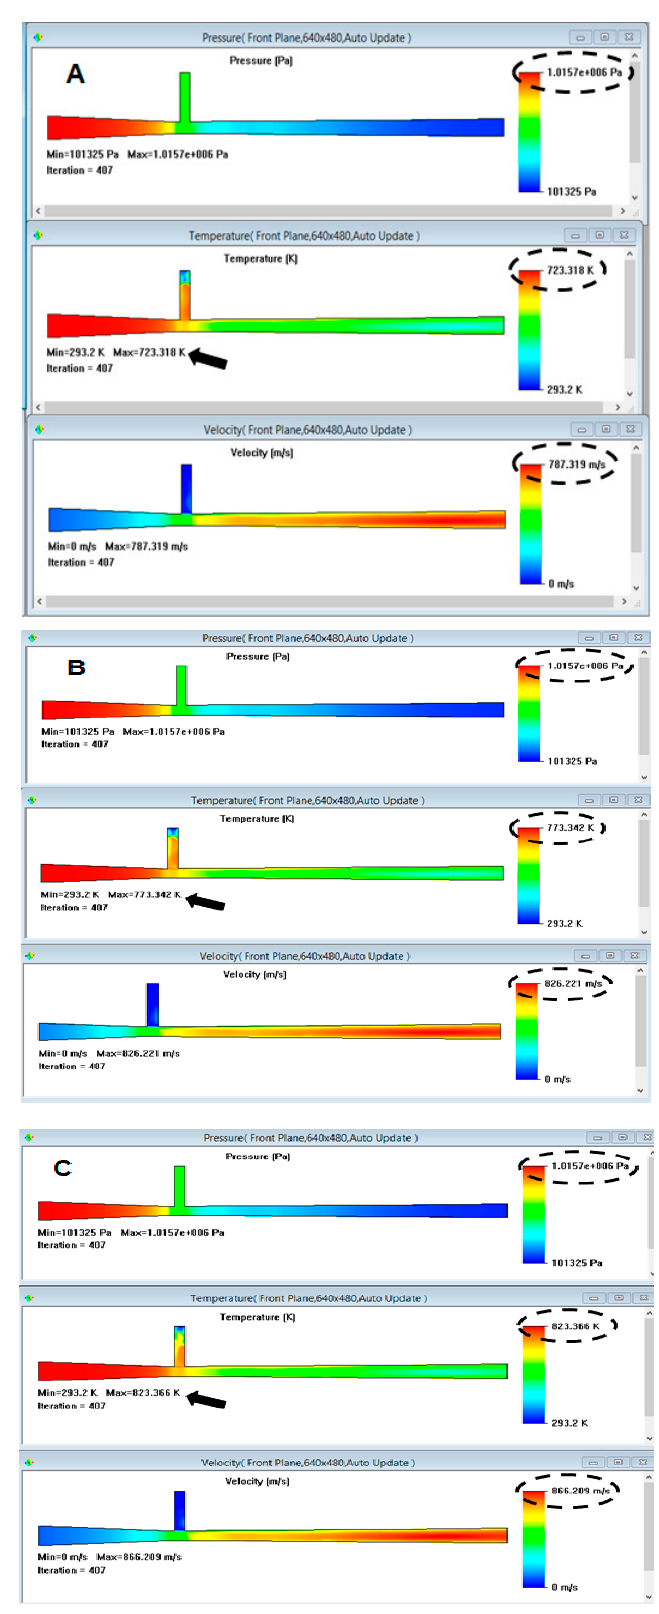
Figure 3. Computational fluid dynamics (CFD) predictions of the exit velocity for the three temperatures: ( A ) at T 1 = 723 K, ( B ) at T opt = 773 K, and ( C ) at T 2 = 823